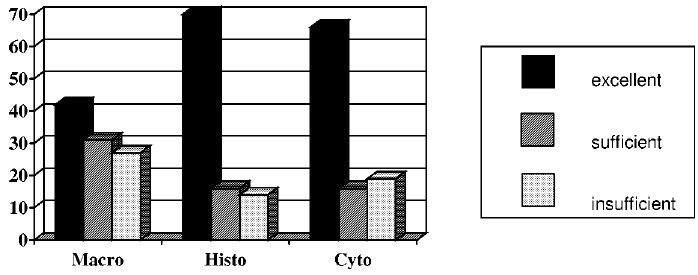
Fig. 3. Distribution of 1234 TP images in quality categories regarding macroscopy, histology and cytology (viewed images in percent).